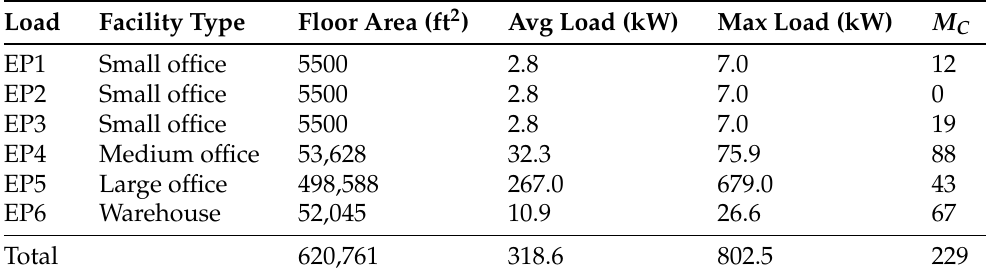
Table 2. Facility load data for NSA Monterey. Mission impact ( M C ) scores were assigned using